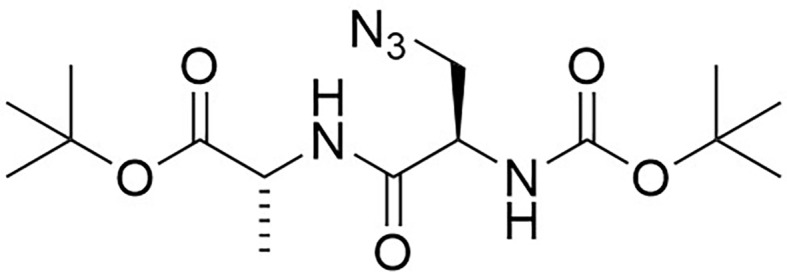
Structure of 3-Azido-N-[(1,1-dimethylethoxy)carbonyl]-D-alanyl-D-alanine 1,1-dimethylethyl ester (Boc-D-aza-ala-D-ala-OtBu).